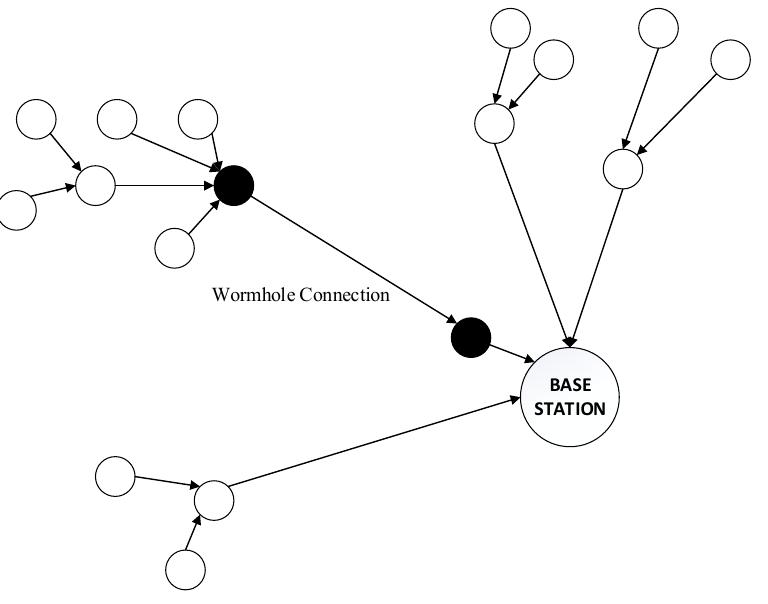
Figure 6. Demonstration of a Wormhole Attack. Selective Forwarding Attack: In this attack, the malicious node can accept and forward some of the incoming packets and reject other packets and drop the packet. The malicious node may/may not accept packets based on specific criteria. For example, it can forward all packets from a particular node and reject them from another node. The illustration of a Selective Forwarding Attack is given in Figure